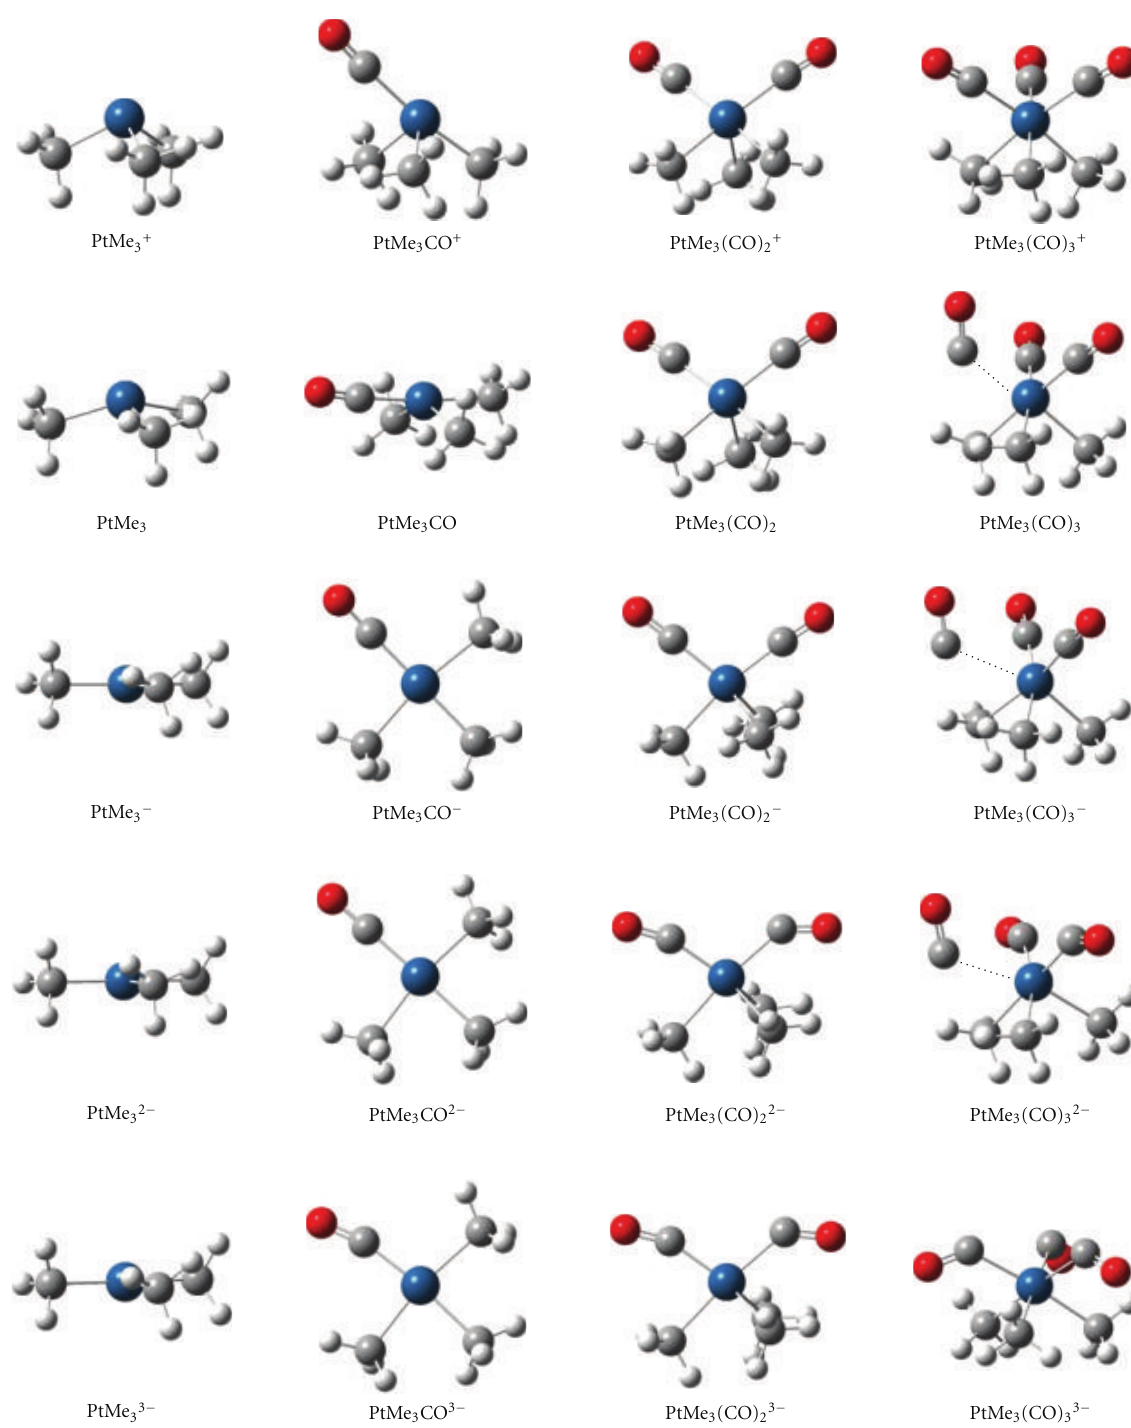
Figure 21: Optimized geometries of alkylplatinum model compounds [114]. Legend: dark grey = carbon, light grey = carbon, red = oxygen, blue =